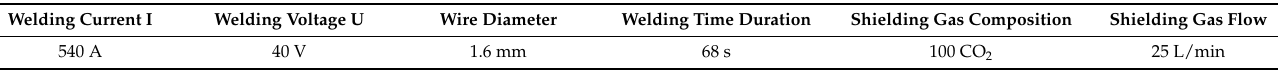
Figure 2. Geometry and dimensions of welded pipes (dimensions in millimeters). Table 1. Main welding parameters.